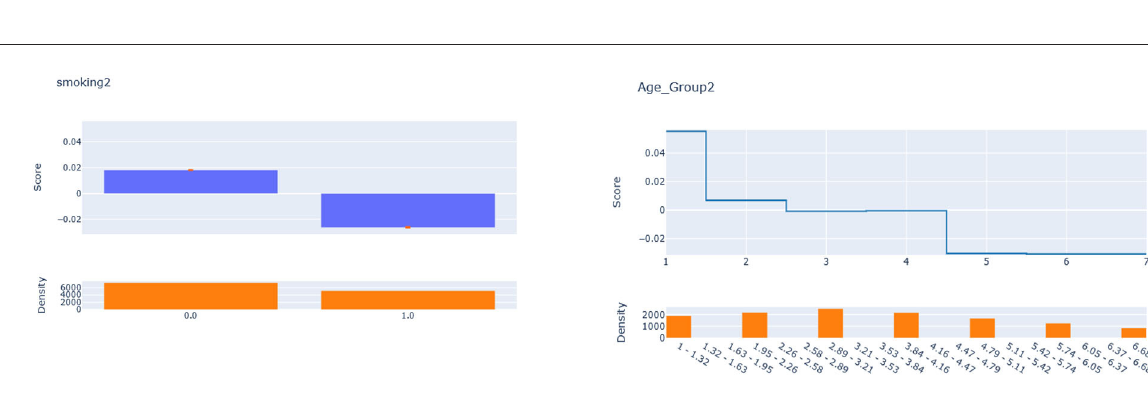
C _ ML i . (Left) IHD, (Right) Diabetes.